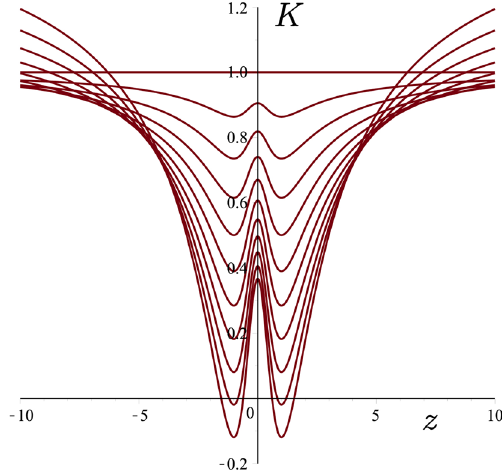
Fig. 1 Plot of K = y − zy (cid:5) + 2 z 2 y (cid:5)(cid:5) in terms of z = P S for γ = 0 . 0000 to γ = 1 . 0000 with equal steps ( = 0 . 1000) from top to bottom. K remains positive as long as γ < tanh − 1